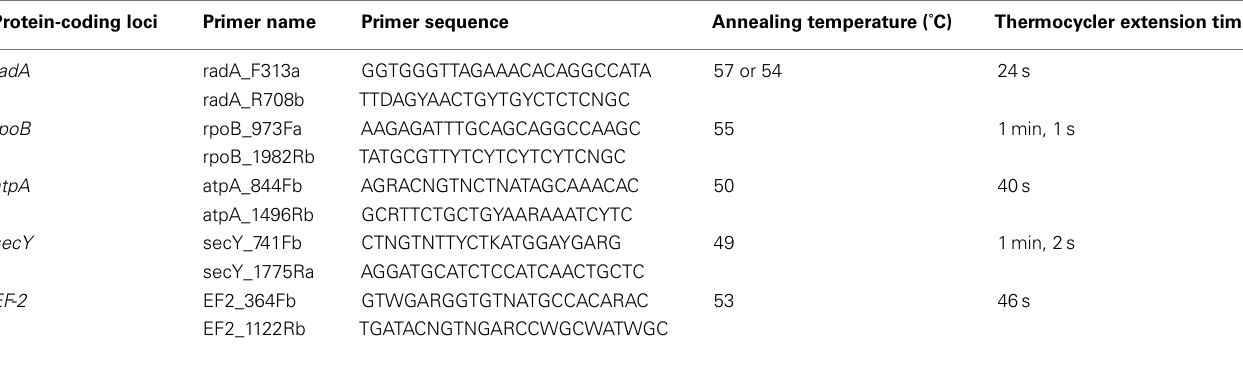
Table 1 | Primers and thermocycler conditions for the amplification of protein-coding loci from DHVE2 isolates. Protein-coding